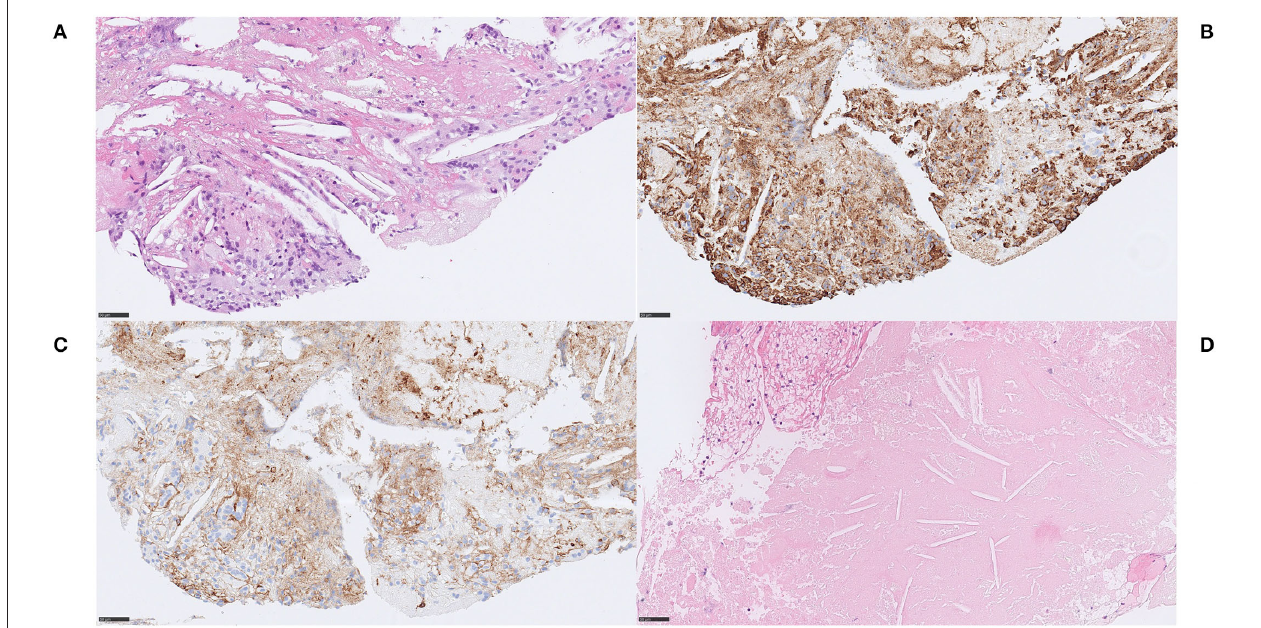
FIGURE 5 | Cholesterol and necrosis. Case 2.3 Cholesterol crystals coalescing into lipid pools, surrounded by both fibrin and platelets (A) H&E, 400x. Cholesterol was accompanied by an inflammatory response, predominantly consisting of macrophages, as indicated immunohistochemically by anti-CD68 (B) CD68PG, 400x, but also lymphocytes and multinucleated giant cells that were identified in direct contact to some of the cholesterol clefts (C) , CD45, 400x. A few cells were immunoreactive for the endothelial marker endothelial transcription factor ETS-related gene (ERG), were noted in association to the inflammatory cells and to the cholesterol, possibly representing endothelial cells (not shown). Other components that may have been expected in embolized stroke thrombi material from an atherosclerotic plaque, such as fibrosis or evident parts of fibrous cap, were not identified. Composition of usual stroke elements was ordinary and unremarkable. Case 2.1 Multiple, large, and well-delineated areas of necrosis measuring up to 2mm, containing cholesterol clefts within the necrotic debris (D) , H&E, 400x. Some mono-nuclear cells were neighboring the necrosis but there were no signs of an active or significant inflammatory response, indicating a short time from necrotic material entering the blood stream to thrombectomy. Red blood cells constituted 75% of the thrombus. Mineralization, common in atherosclerotic plaques, was not identified. Scale bar = 50 µ